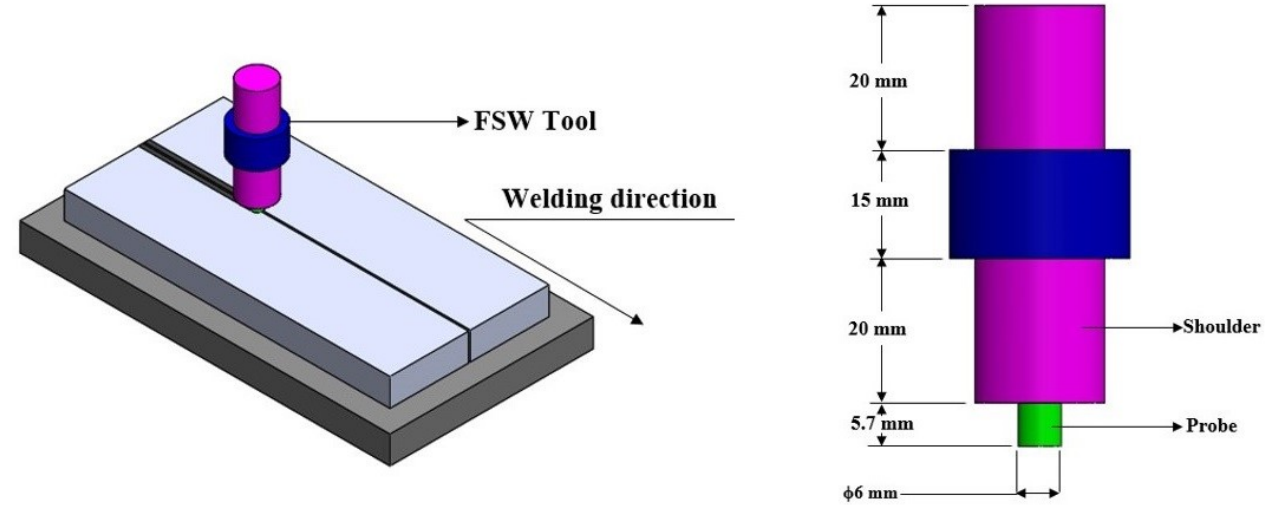
Figure 3. Friction stir welded specimen.